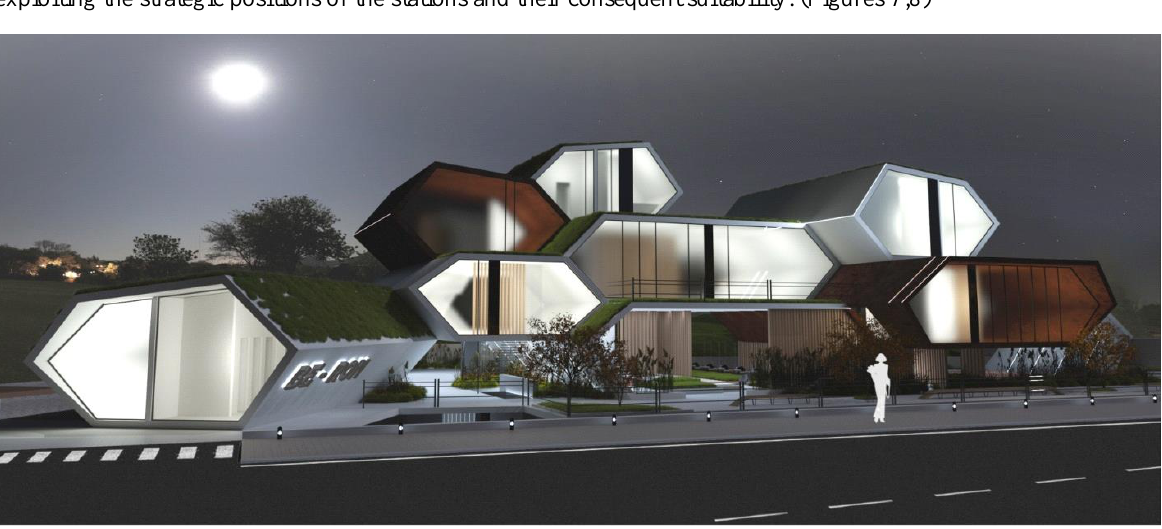
Figure 8 Gherardo Selvatici, Florenze Smart City, Florence School of Architecture, 2020